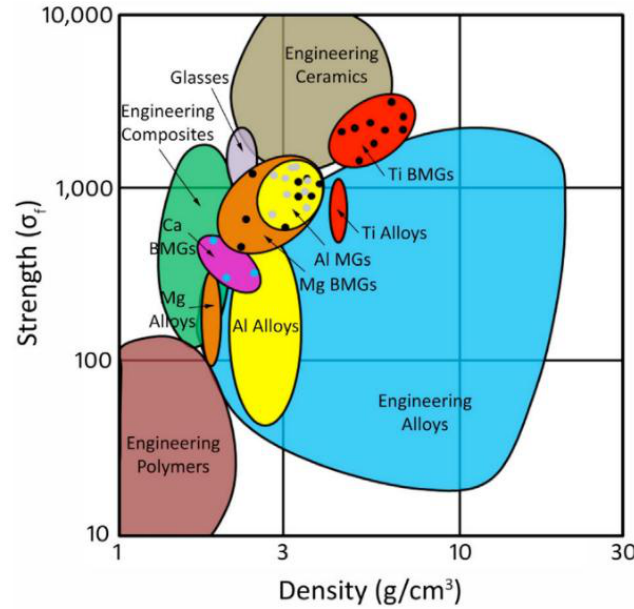
Figure 10. The Ashby diagram of strength versus density for engineering materials. Reproduced with permission from [29]. Copyright 2014, John Wiley and Sons.